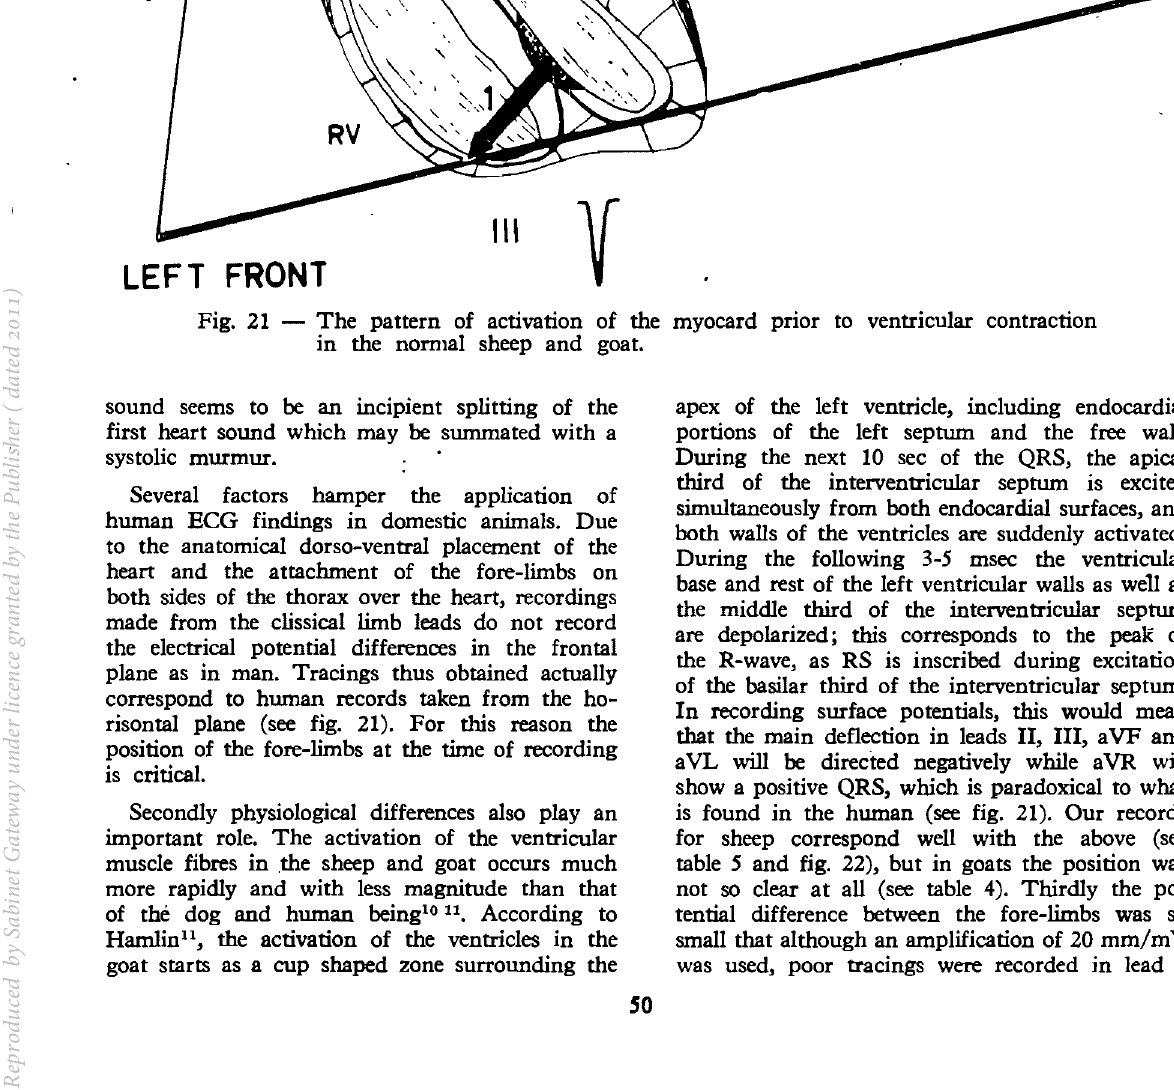
Fig. 21 - The pattern of activation of the myocard prior to ventricular contraction in the normal sheep and goa